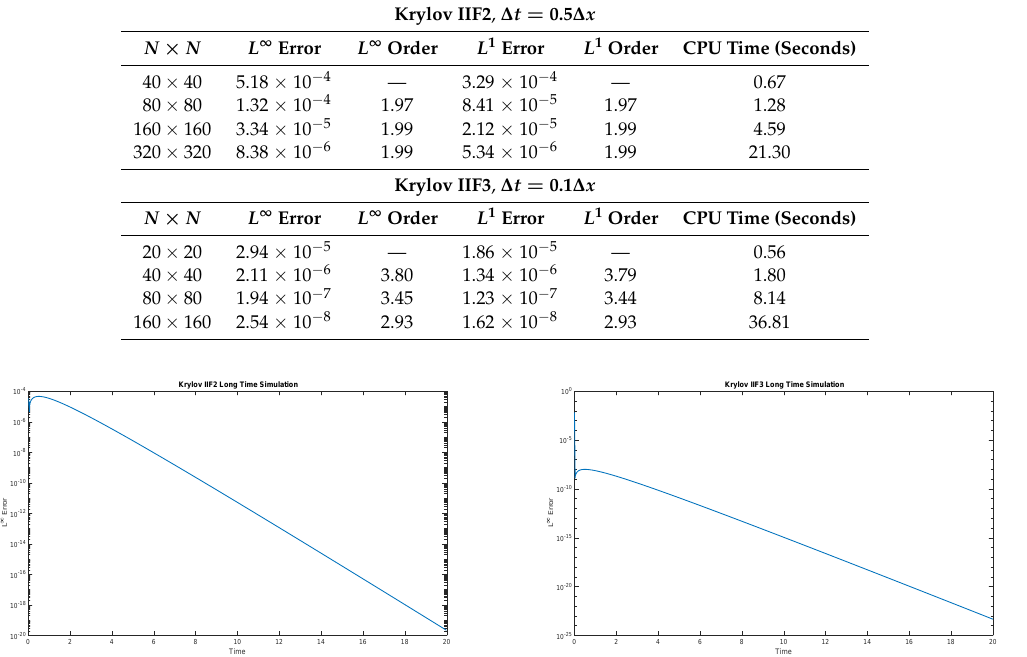
Figure 3. Example 4. A two-dimensional system of equations with stiff reactions. Plots of history of long-period integration errors in L ∞ norm for Krylov IIF2 and IIF3 schemes. The ratio of eigenvalues of reaction terms is 1000. The spatial mesh is 160 × 160. Time-step sizes: ∆ t = 0.5 ∆ x for Krylov IIF2 scheme and ∆ t = 0.1 ∆ x for Krylov IIF3 scheme. Krylov subspace dimension: M = 10. Simulations run from t = 0 to the final time t = 20. Left picture: error history for Krylov IIF2. Right picture: error history for Krylov